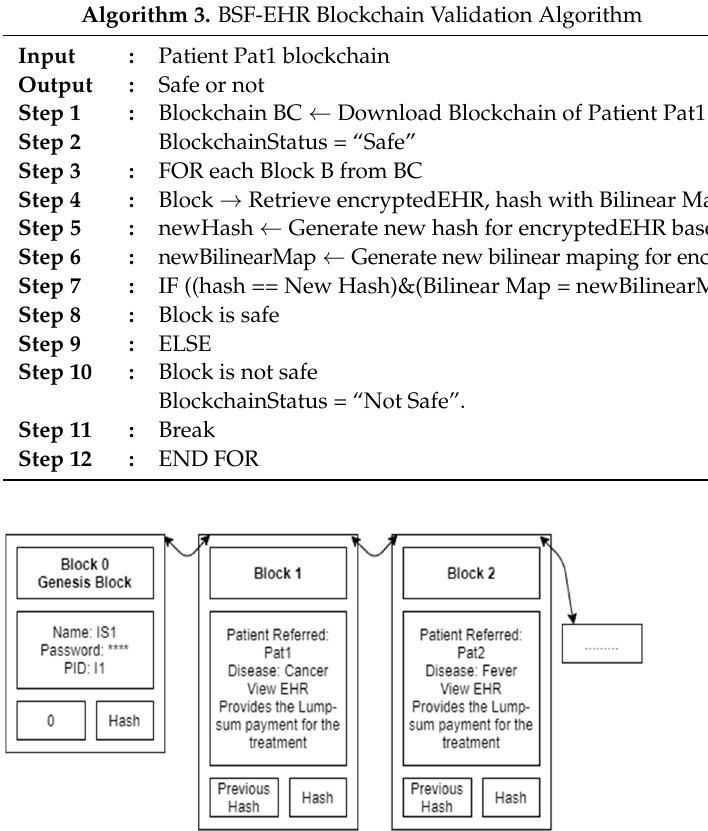
Algorithm 3. BSF-EHR Blockchain Validation Algorithm